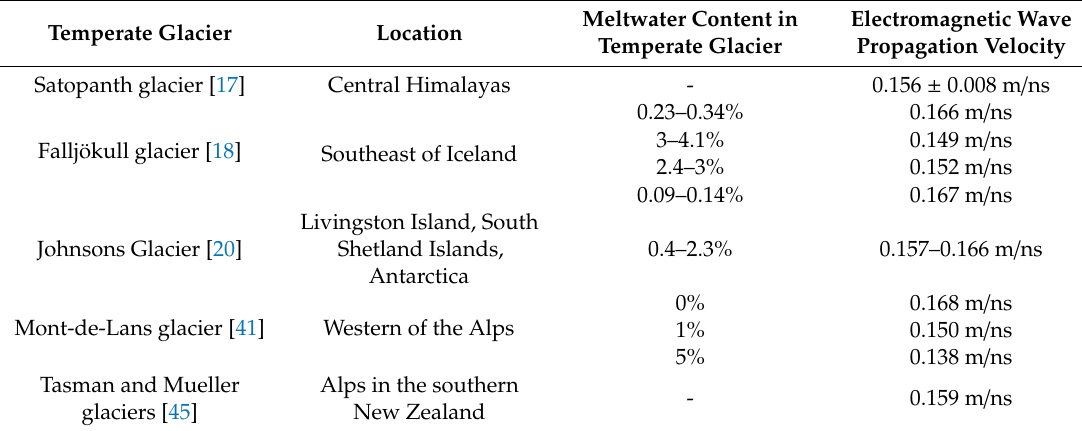
Table 1. Descriptive statistics in the electromagnetic wave propagation velocity variation with the meltwater content of temperate